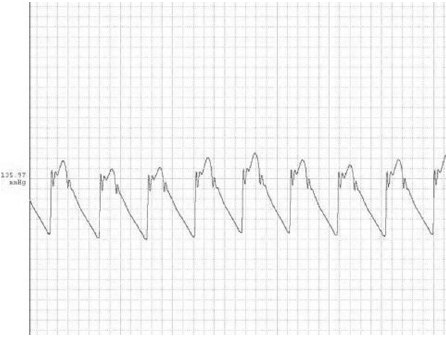
Figure 1 - Characteristic systemic pressure waveform in the aortic arch